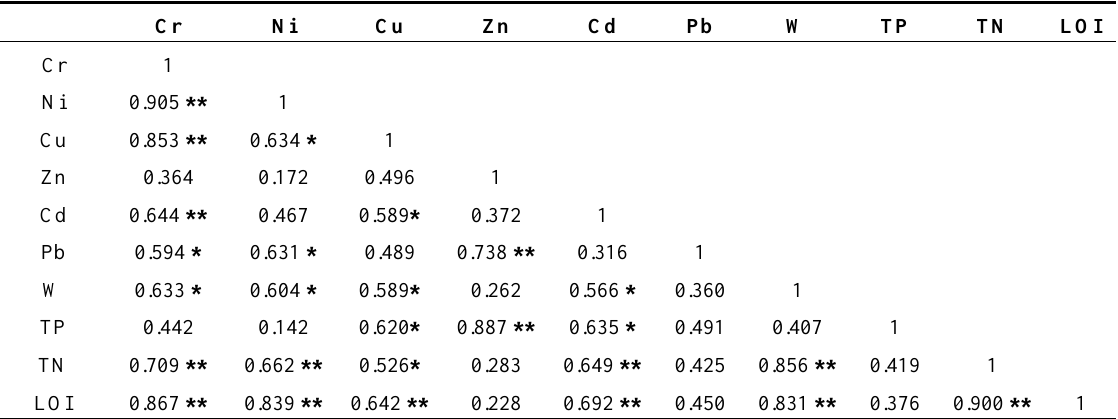
Table 3. Pearson correlation matrix for metal concentrations, W, LOI, TP, and TN. Cr Ni Cu